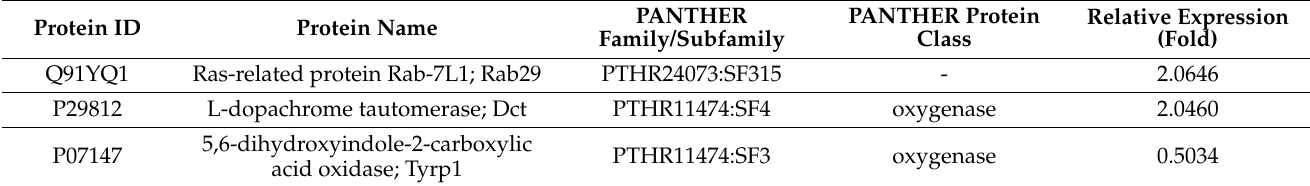
Table 1. The list of identified proteins in pigmentation (Gene Ontology; (GO): 0043473) that are directly associated with tyrosinase.